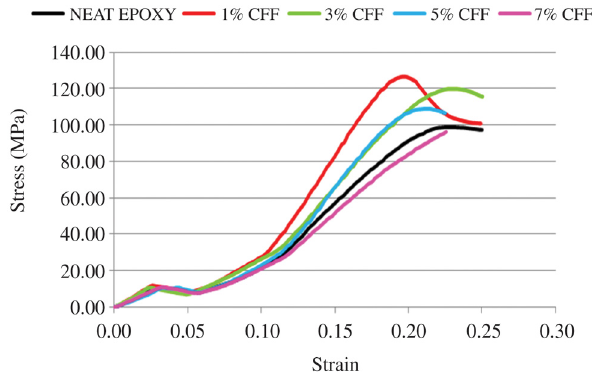
Figure 13: Compressive stress-strain behavior of various compositions of CFF composite.